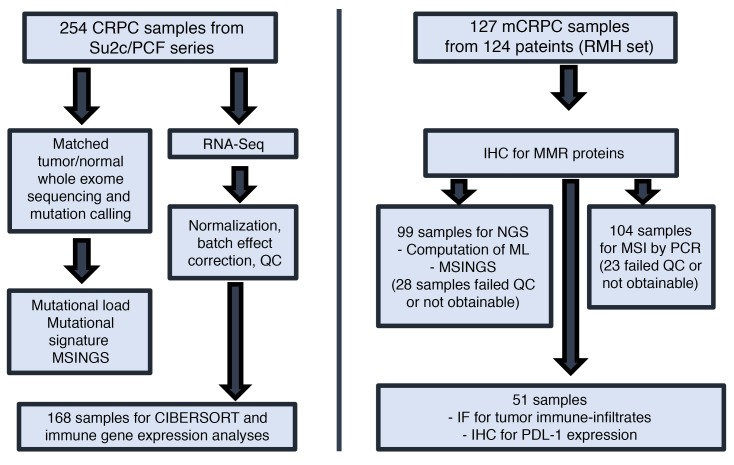
Consort diagram.Assays performed on 2 different cohorts of sample patients from the Royal Marsden Hospital (RMH) and the Stand Up To Cancer/Prostate Cancer Foundation (SU2C/PCF) database. ML, mutational load; QC, quality control.